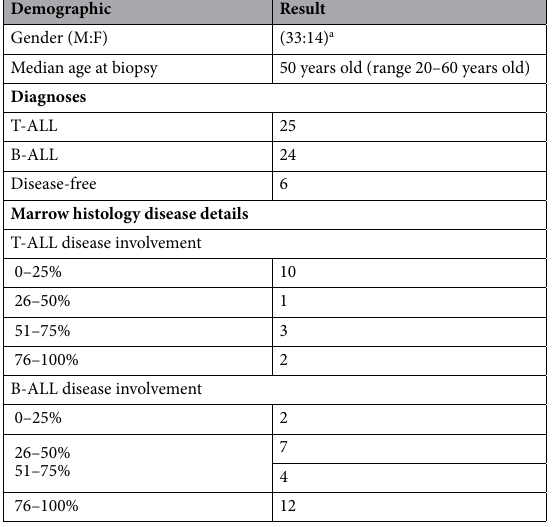
Table 1. Patient demographics. Summary of patient samples from Fred Hutch biorepository. a Patients whose peripheral blood and marrow samples were used for RT-qPCR or Protein Wes Simple (n = 14) were completely de-identified prior to inclusion in this study. No demographic information is available for these patients beyond their T-ALL